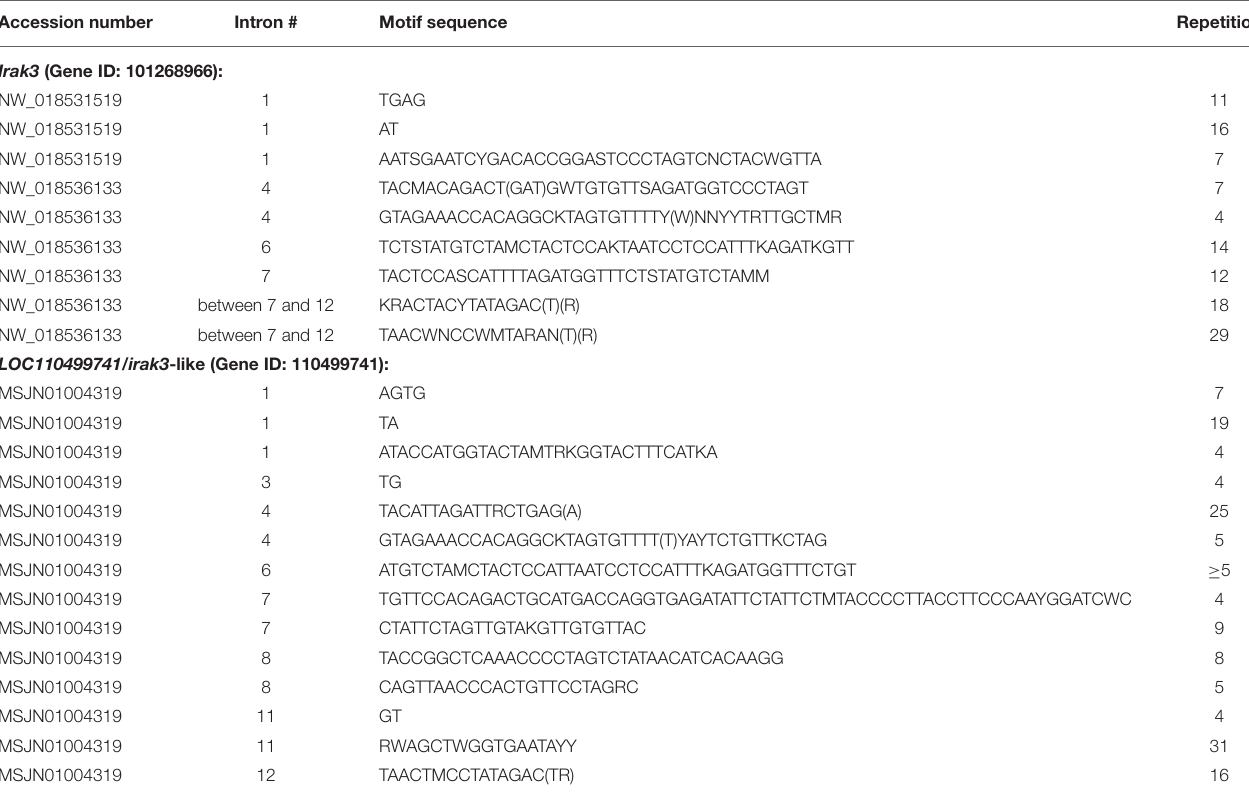
TABLE 2 | Repetition of DNA elements (at least four-fold) within trout irak3 genes (bases follow the standard IUPAC nucleotide